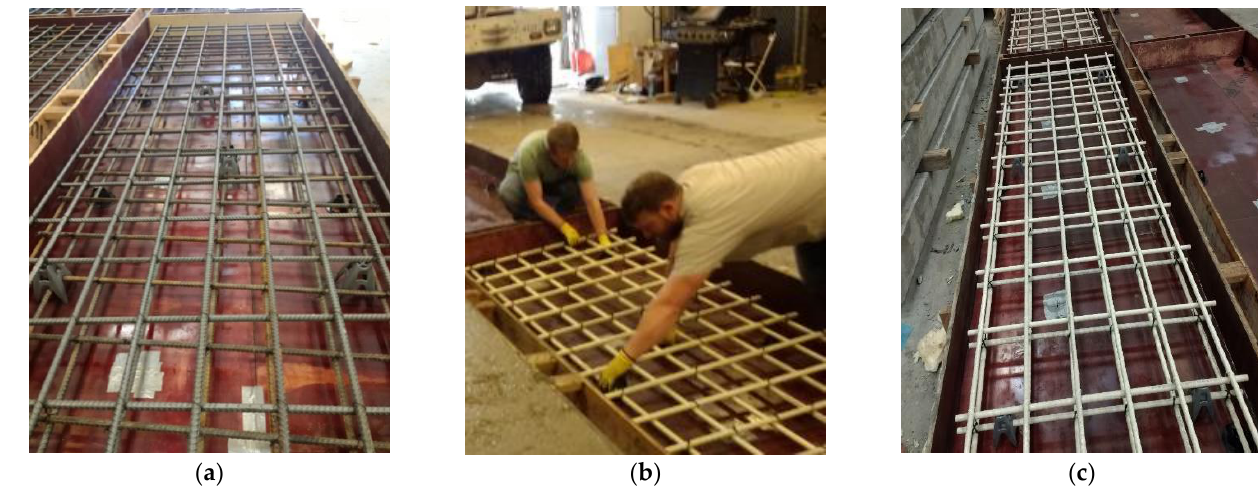
Figure 3. Photos of specimens prior to pouring the concrete ( a ) Steel-Reinforced Decks, ( b ) GFRP- Reinforced Decks, and ( c ) Hybrid Decks.